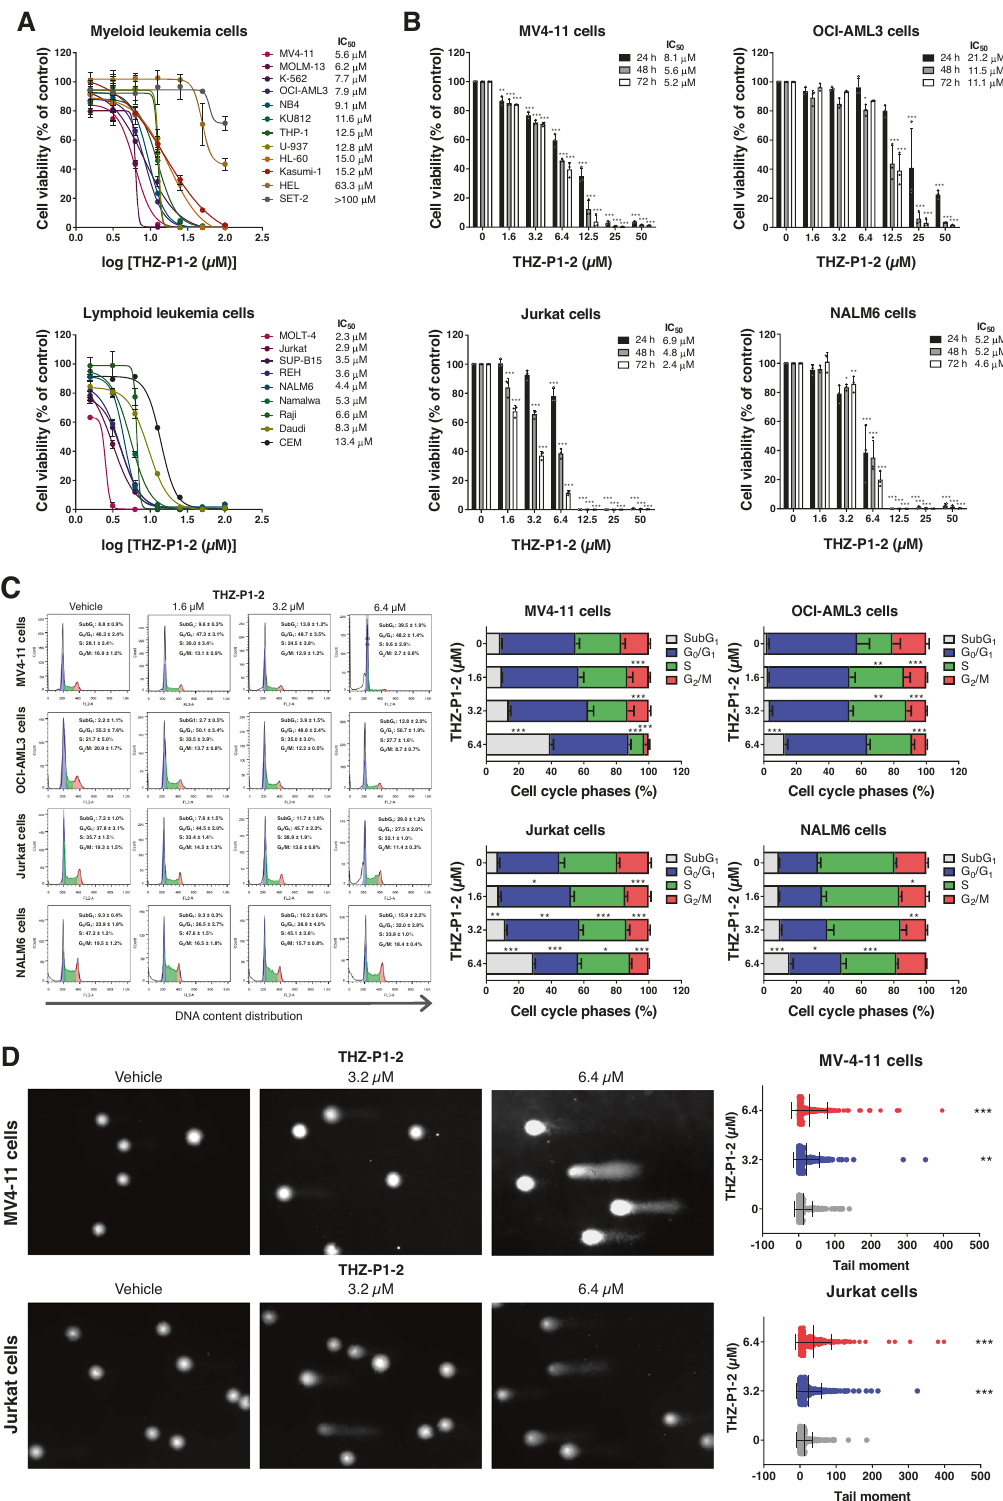
observed in MV4-11 and Jurkat cells. (Fig. 2A). In line with our apoptosis data, we also observed a signi fi cant loss of mitochon- drial membrane potential (MMP), indicating mitochondrial damage (Fig. 2B). However, the loss of MMP was not directly correlated with the frequency of apoptotic cells, especially in